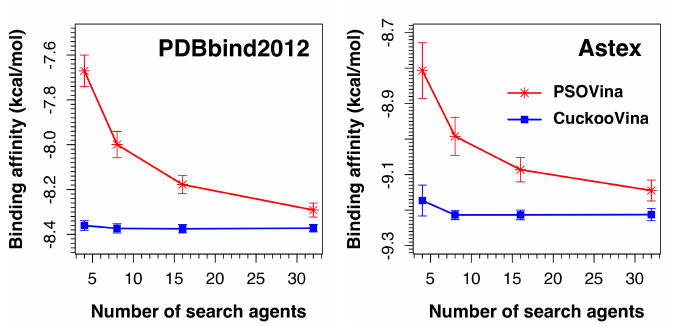
Figure 5. Effects of the number of search agents (4, 8, 16, and 32) on the docking performances of PSOVina and CuckooVina using the PDBbind 2012 and Astex datasets. Experiments were performed using 30 docking